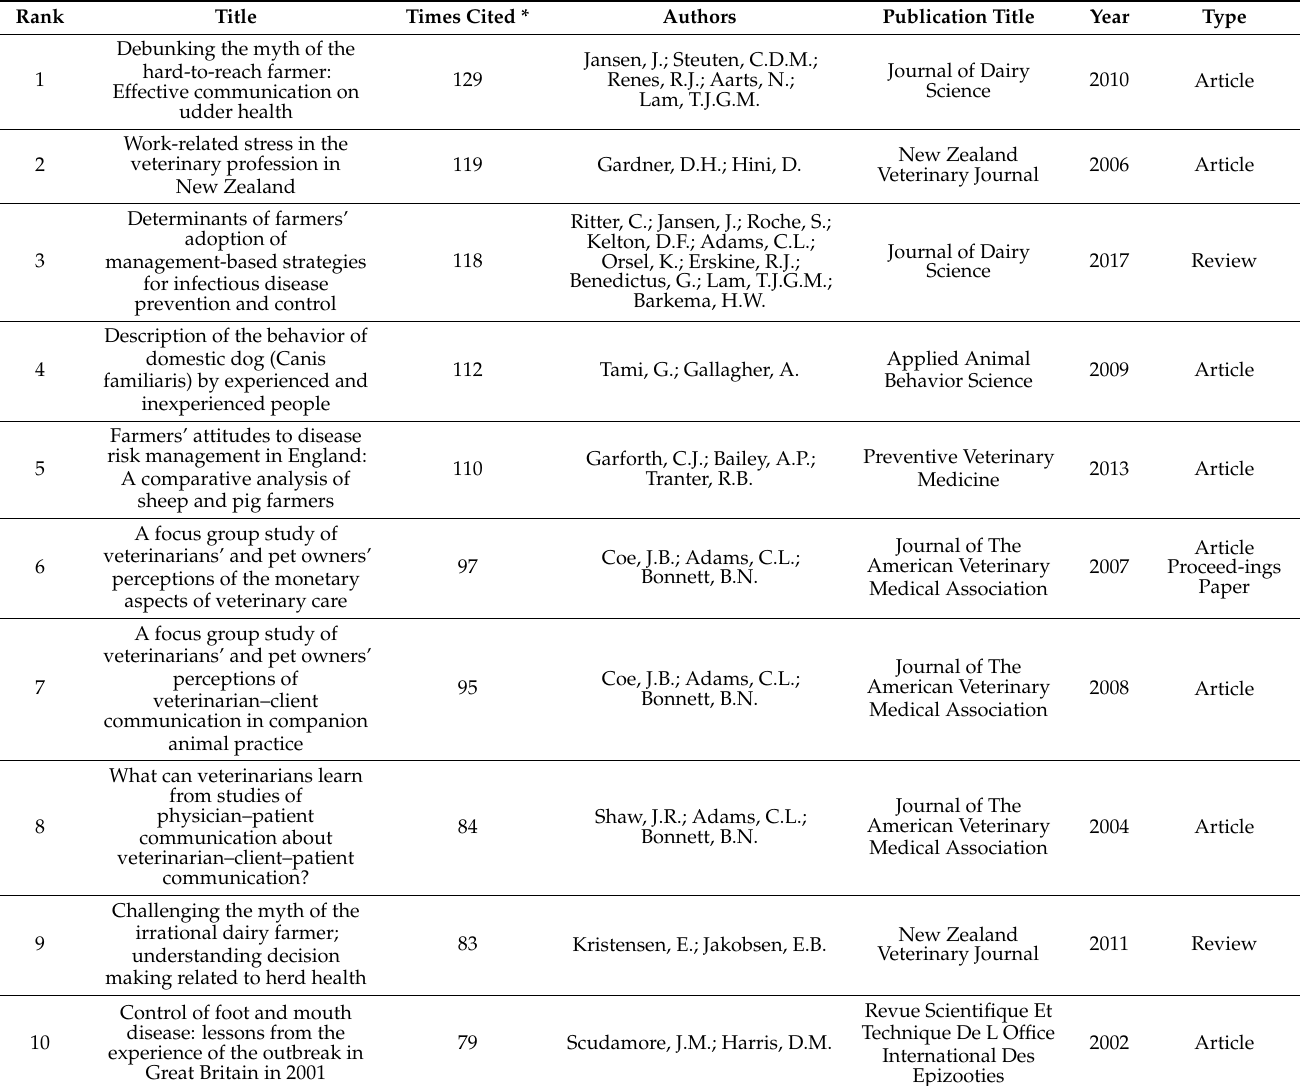
Table 2. The top 10 highly cited publications in veterinary communication education (VCEPs) from 2000 to